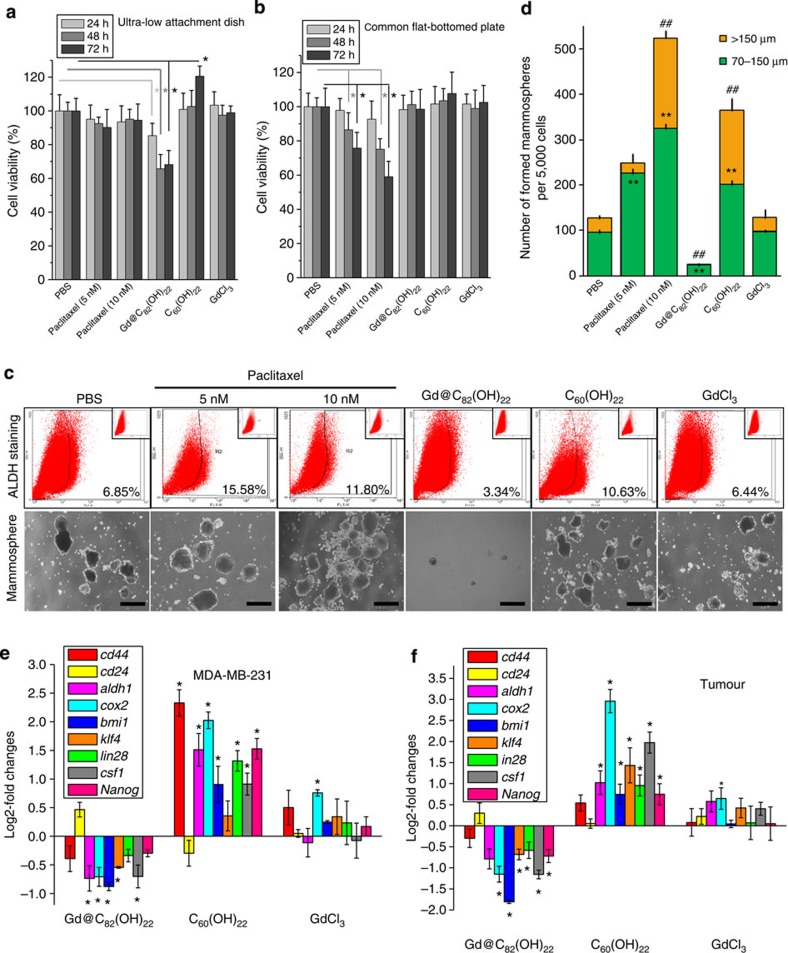
Gd@C82(OH)22 nanoparticles effectively eliminate CSCs and tumour initiation.(a,b) MDA-MB-231 cells were cultured in adherent monolayer culture or ultra-low attachment dish for 10 days, and treated with PBS, Paclitaxel (5 or 10 nM), Gd@C82(OH)22, C60(OH)22 or GdCl3 (all 50 μM) for another 24, 48 or 72 h. The cell viability was determined (mean±s.e.m., n=3 each). *P<0.05 (two-way ANOVA, Bonferroni’s post-hoc test). (c) Tumoursphere formation of MDA-MB-231 cells after treatment for 21 days (scale bar, 100 μm). (d) The tumourspheres were quantitated (mean±s.e.m., n=3 each). To tumourspheres of 70–150 μm, **P<0.01; to tumourspheres of >150 μm, ##P<0.01 (one-way ANOVA, Tukey’s post-hoc test). (e) mRNA levels of CSC markers were analysed by qPCR (mean±s.e.m., n=3 each). *P<0.05 (one-way ANOVA, Tukey’s post-hoc test). (f) A total of 1 × 106 MDA-MB-231 cells were injected into the right back flanks of the mice s.c. Mice were monitored and treated daily. mRNA level of CSC markers in tumour tissue were analysed by qPCR (mean±s.e.m., n=3 each).